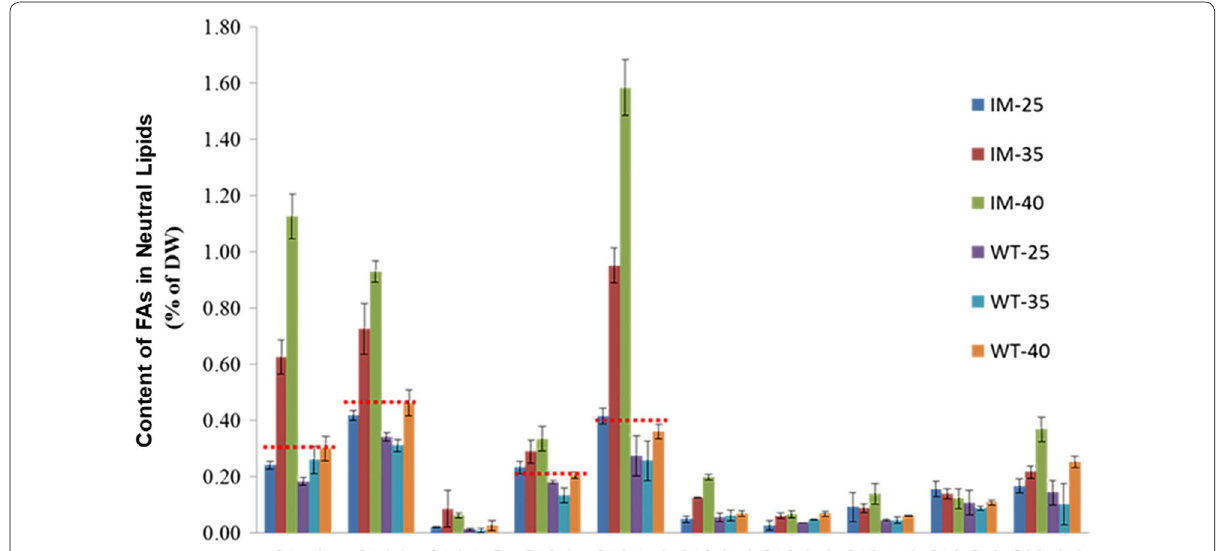
SD of three individual ±